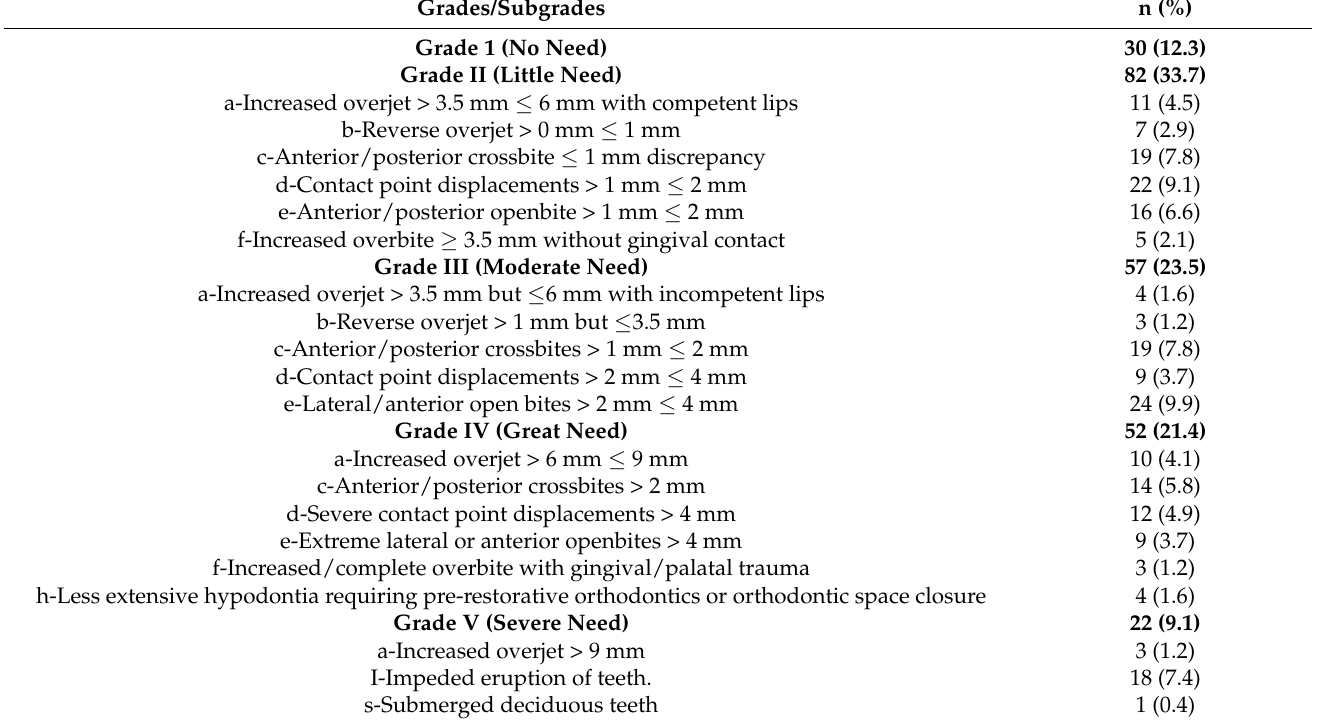
Table 2. Frequency and percentage distribution of prevalent IOTN-DHC grades/subgrades (n = 243).